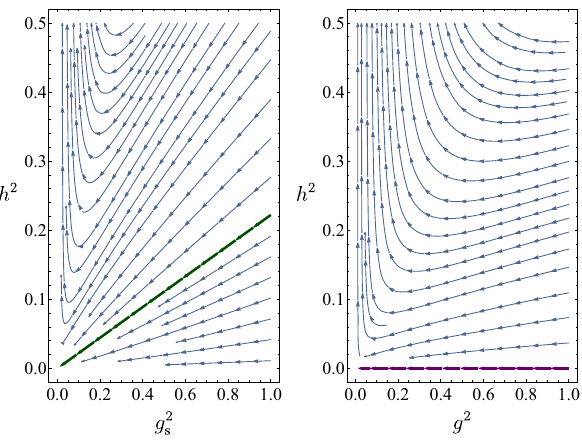
Fig. 1 Left panel: the one-loop RG flow of the model with SM-like matter content in the DER projected onto the ( h 2 , g 2 s ) plane. The UV repulsiveQFPtrajectoryhighlightedbythegreenlinecorrespondstothe solution in Eq. (18). Right panel: the corresponding RG flow projected onto the ( h 2 , g 2 ) plane. The UV repulsive QFP trajectory highlighted by the purple line corresponds to the trivial solution h 2 = 0. The arrows for both flows are pointing towards the